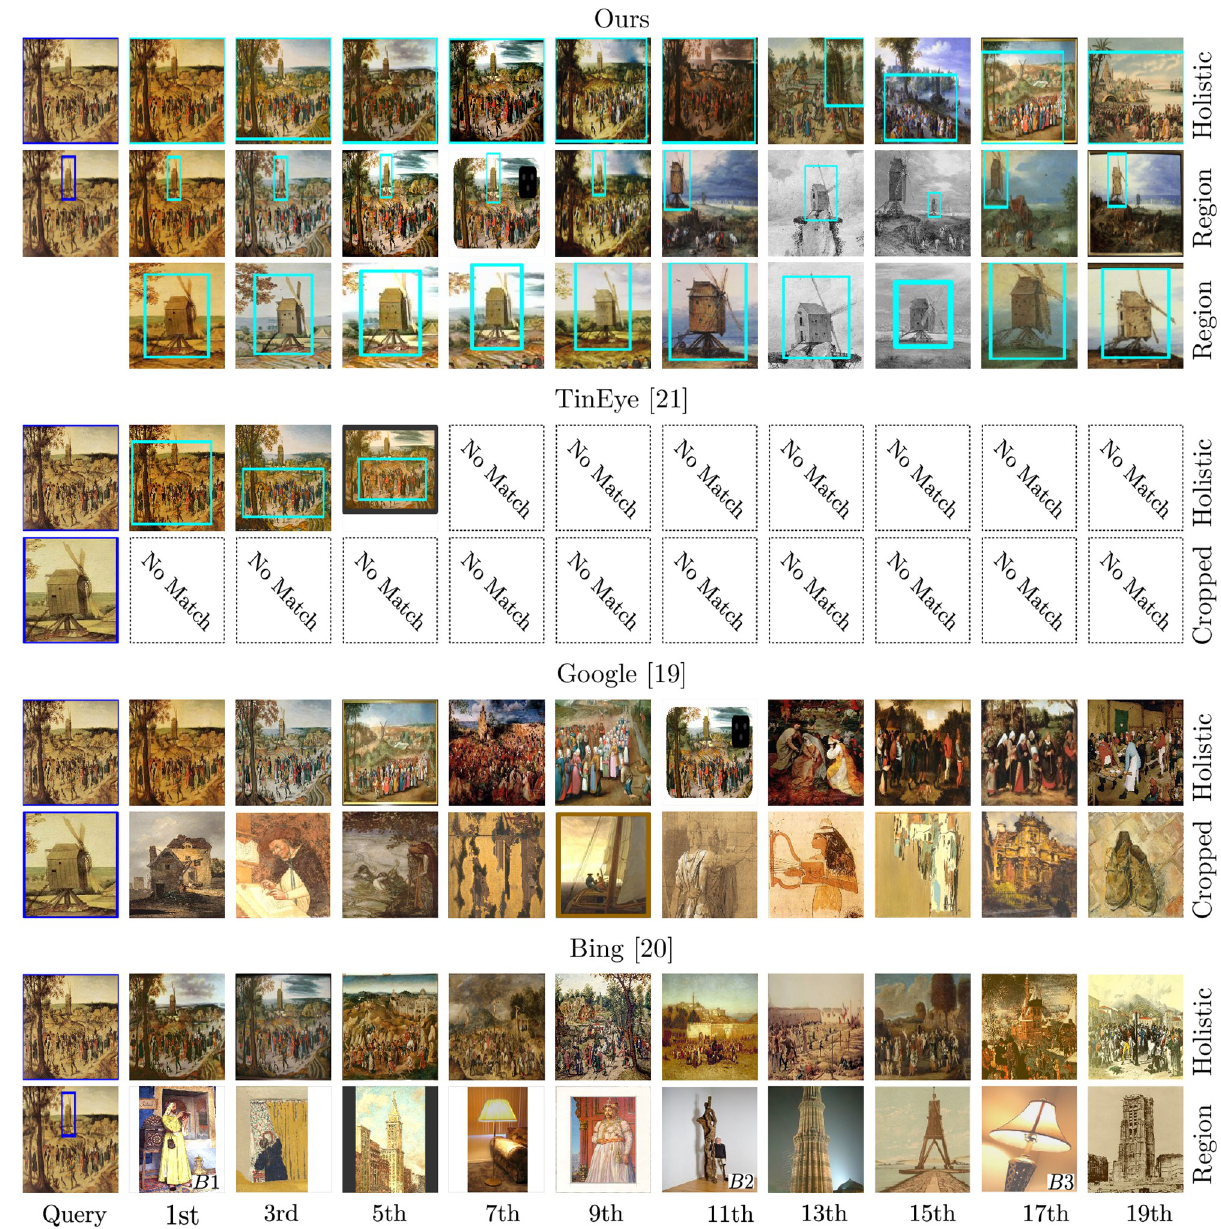
Fig 13. Qualitative comparison with TinEye, Google and Bing image search. We show retrieval examples for a given query on a modified Brueghel dataset for our algorithm and TinEye [22] and on the web for Google [20] and Bing [21] image search, where we made sure that all algorithms can find all visualized retrievals. We show results for a holistic image search (Holistic) as well as on the cropped (Cropped) and marked region (Region). In addition, we visualize retrievals in full screen (first row) and zoomed-in version (second row) for our results of the regional search. Due to copyright issues, we replaced several images. We made sure that the replacements are as similar as possible to the originals. The original figure is also available on our project website. Image (B1) and (B2) are slight modifications of [97, 98] licensed under CC BY 3.0. Image (B3) is a slight modification of [99] licensed under CC BY 2.0. The remaining image material is shared by Wikimedia Commons [5] either as public domain or under a CC0